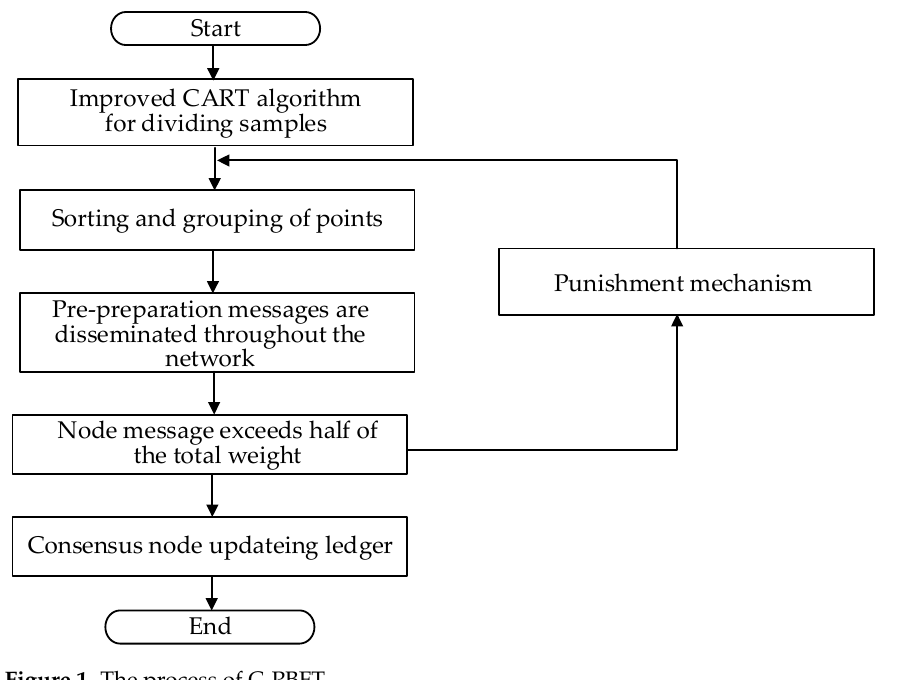
Figure 1. The process of C-PBFT.